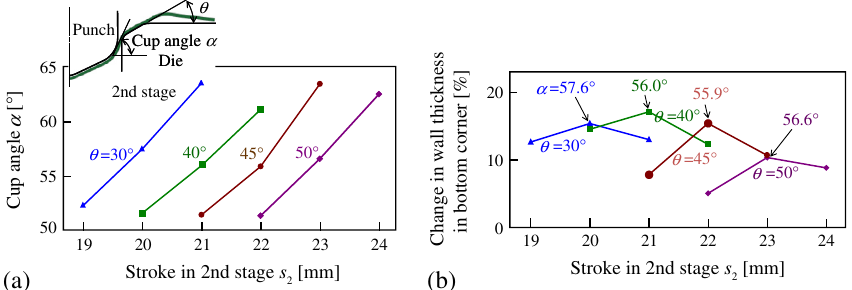
Figure 13. Effect of conditions in 2nd stage on change in wall thickness in bottom corner. (a) Cup angle after 2nd stage and (b) effect of cup angle after 2nd stage on change in wall thickness in bottom corner.